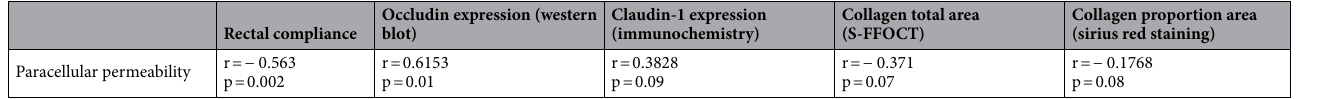
Table 3. Spearman’s correlation coefficients with paracellular permeability and other